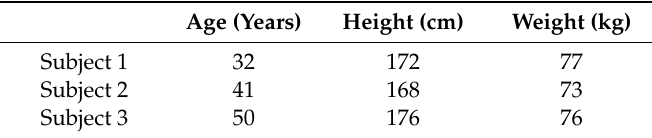
Table 7. The characteristics of the experiment subjects.